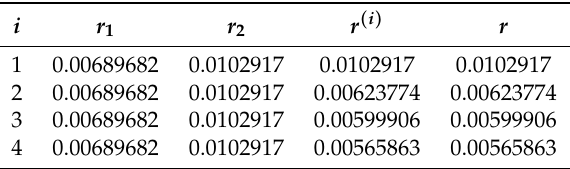
Table 4. Distinct radii of